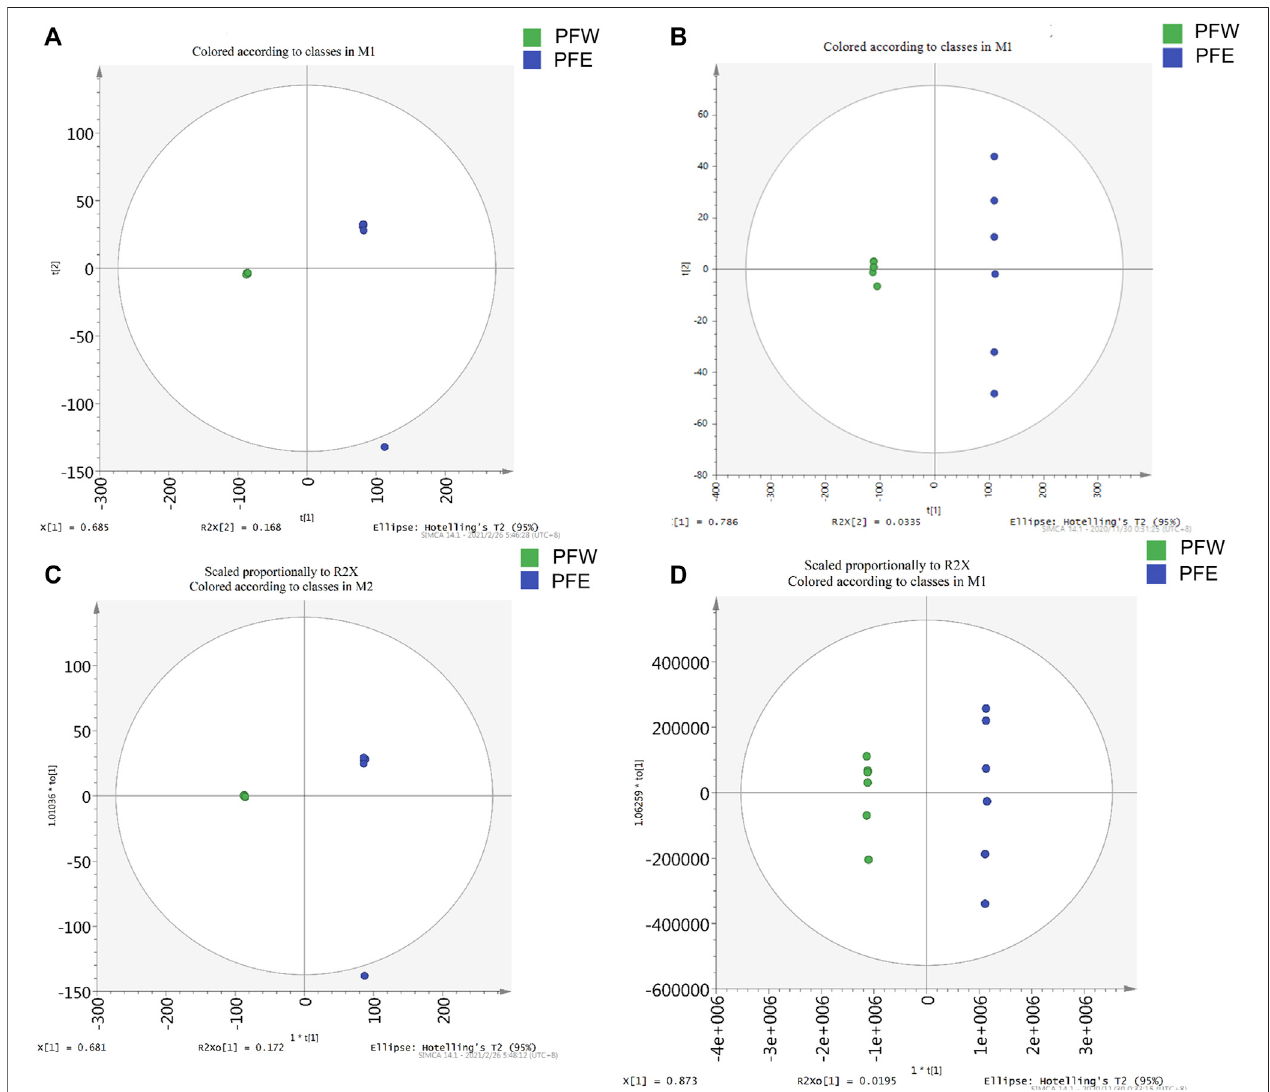
FIGURE 3 | The PCA score plots and OPLS-DA models for the UHPLC-Q-Exactive MS analysis of PFW and PFE. (A) Negative ions mode of the PCA model. (B) Positive ions mode of the PCA model. (C) Negative ions mode of the OPLS-DA model. (D) Positive ions mode of the OPLS-DA model.